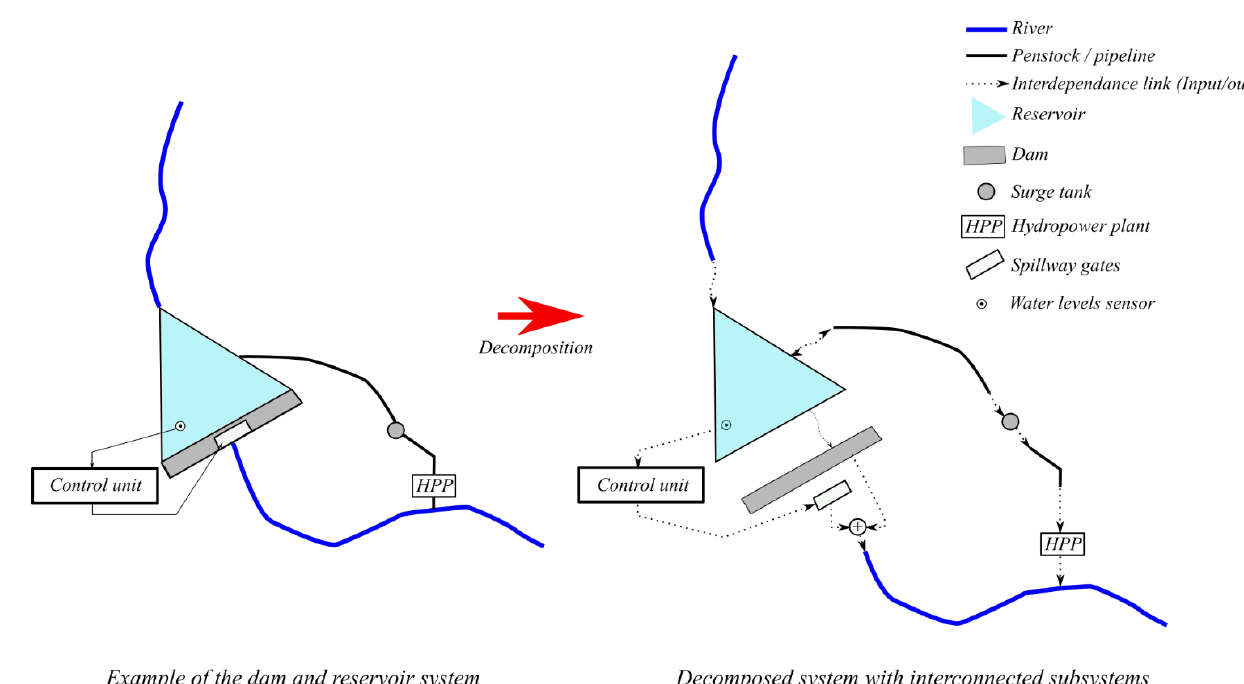
Figure 2. Example of system decomposition and definition of the interdependence links.